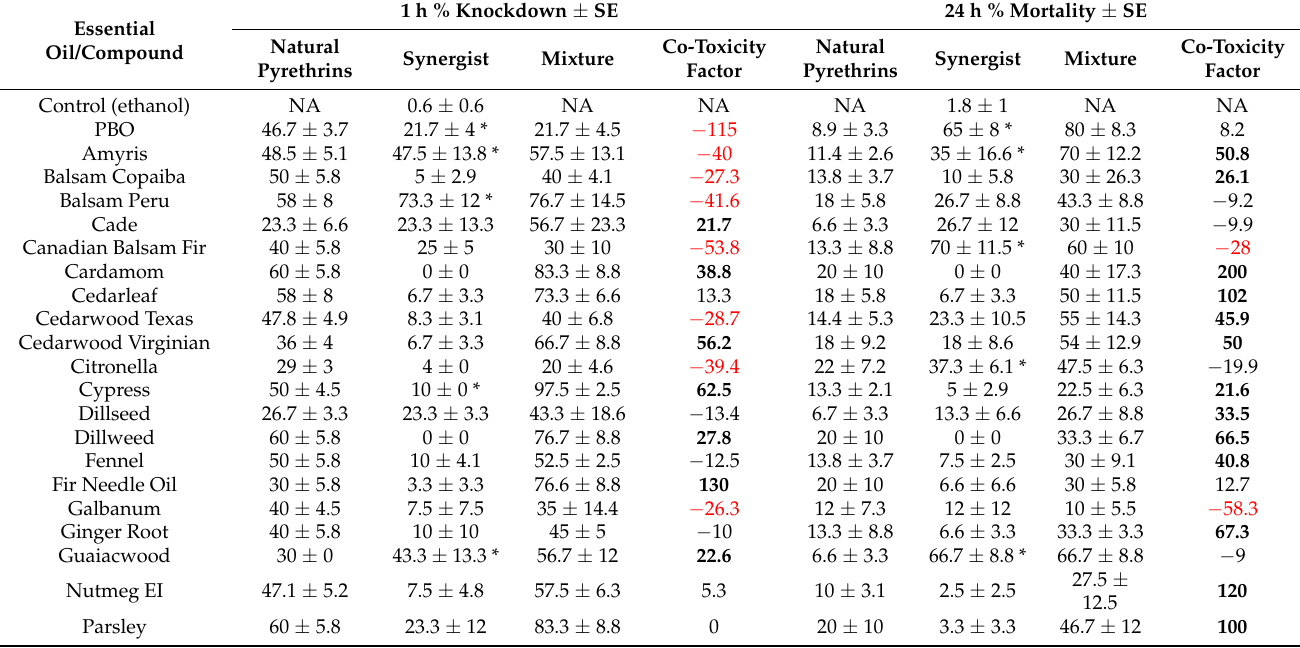
Table 2. Percentage 1 h knockdown and 24 h mortality values for natural pyrethrins (LD 25 ), plant essential oils or piperonyl butoxide (PBO) synergists (10 µ g/insect), mixture of natural pyrethrins + synergist, and the calculated co-toxicity factors for each